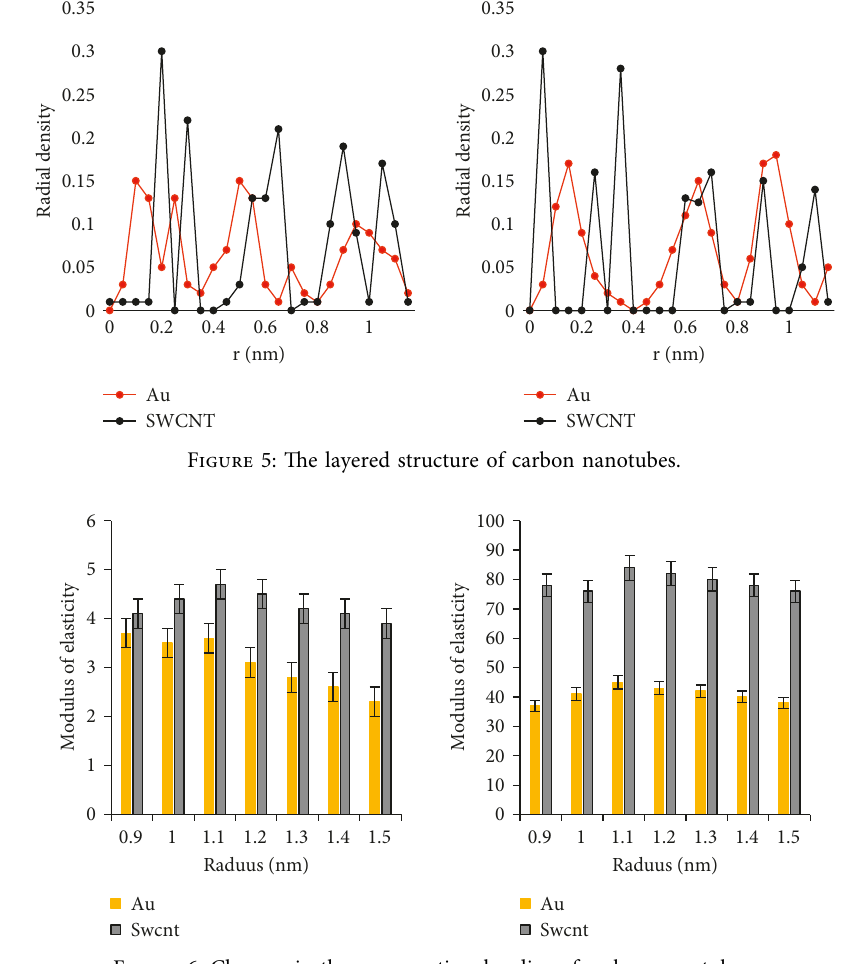
Figure 6: Changes in the cross-sectional radius of carbon nanotubes.